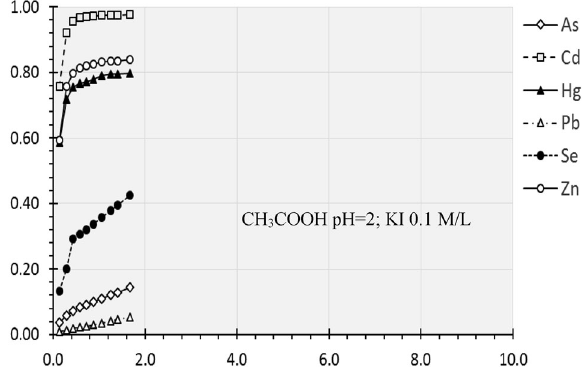
Fig. 10 Leachability of Hg: extraction yield versus volume (L), first test